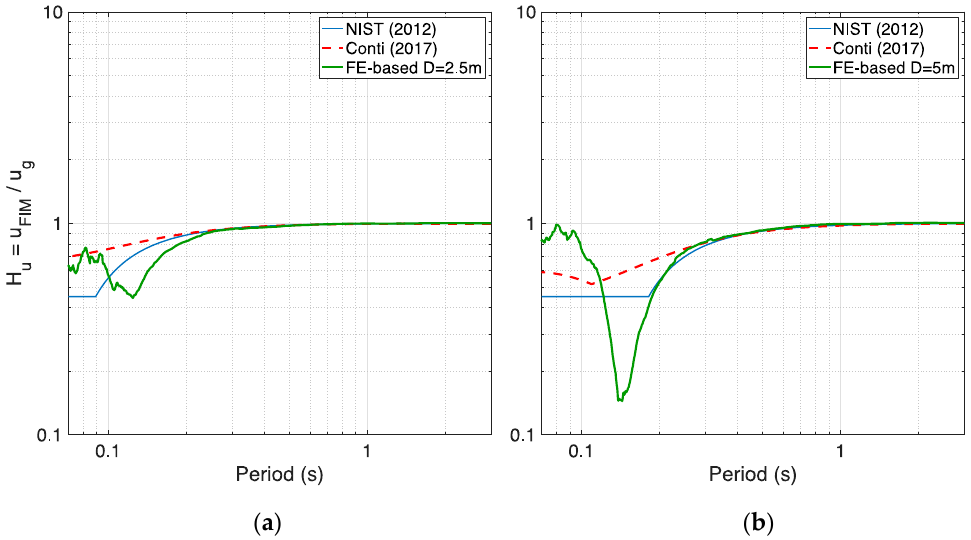
Figure 14. Comparison between analytical transfer functions obtained from two models and FE- based ones for embedment depths of ( a ) 2.5 m and ( b ) 5 m for nonlinear academic soil profile and record “Accel outcrop”.